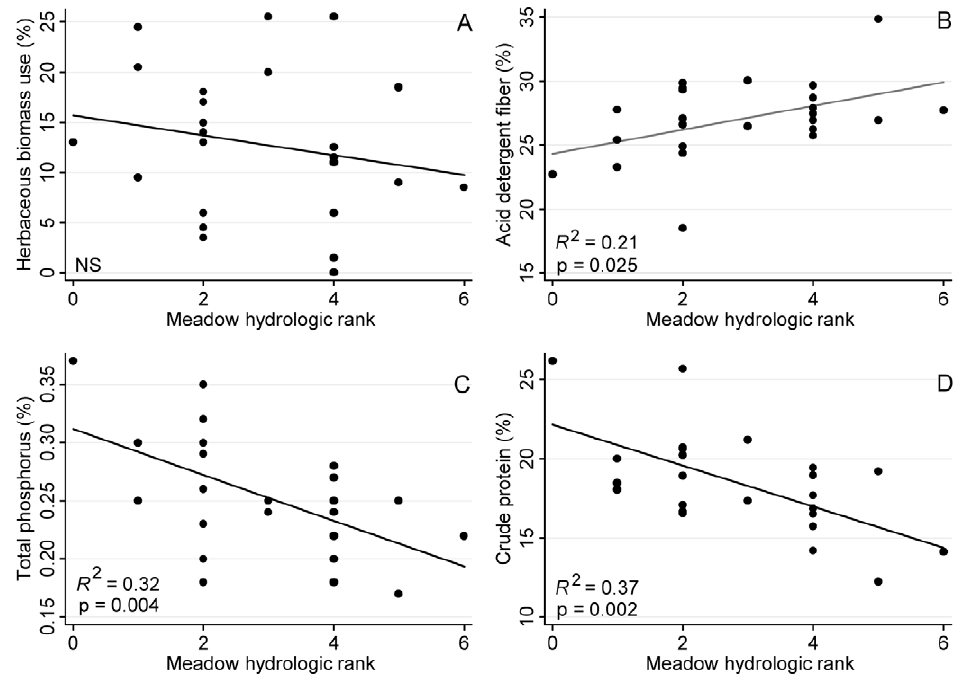
Figure 5. Early season bivariate analyses. Early season (July) meadow scale cattle use and forage quality along a hydrologic gradient of meadows (n=24) in the High Sierra Ranger District, Sierra National Forest, California, USA. There was no significant trend in cattle use, as measured by mean early season herbaceous biomass use, across the meadow hydrologic gradient (panel A). Forage quality (crude protein, total phosphorus [TP], acid detergent fiber [ADF]; panels B–D) significantly declined with increasing meadow hydrologic rank (i.e., meadow wetness).